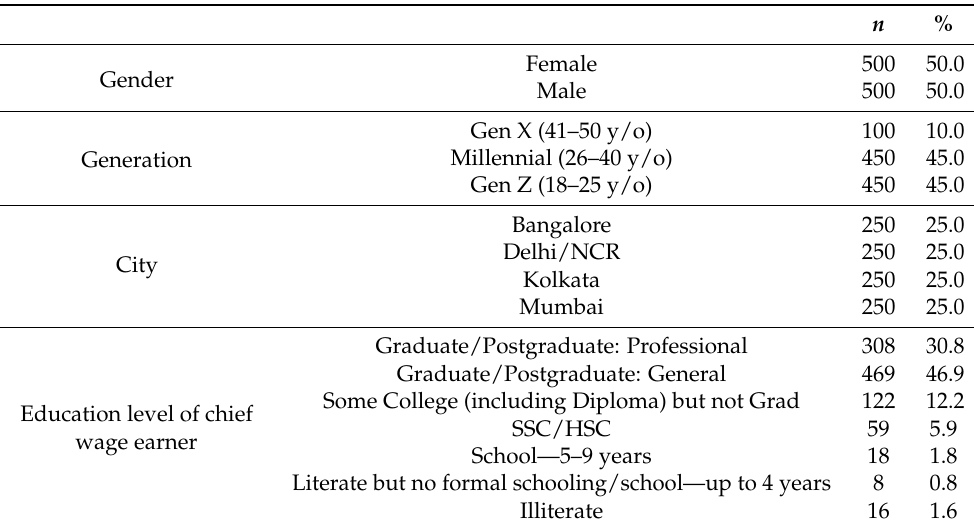
Table 1. Characteristics of study